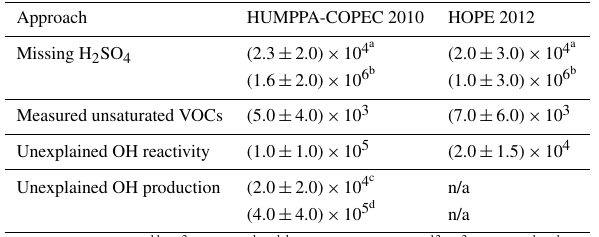
Table 2. SCI estimates for the HUMPPA-COPEC 2010 and HOPE 2012 campaigns. Average concentration (moleculescm − 3 ) , with 1 σ